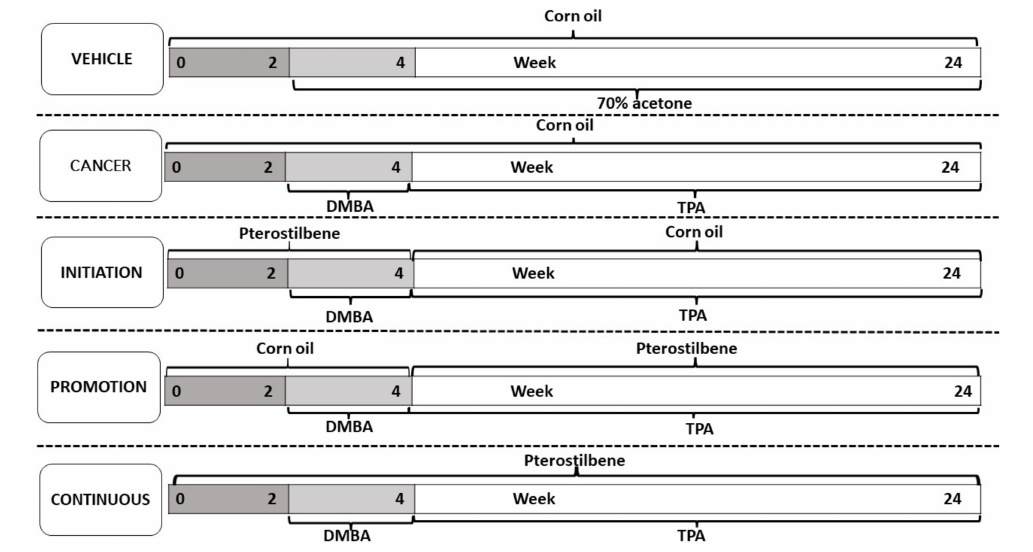
Figure 2. The experimental design of the study for each group was to investigate the chemo- preventive effect of oral pterostilbene during the initiation, promotion, or continuous in DMBA/TPA induced skin carcinogenesis mouse